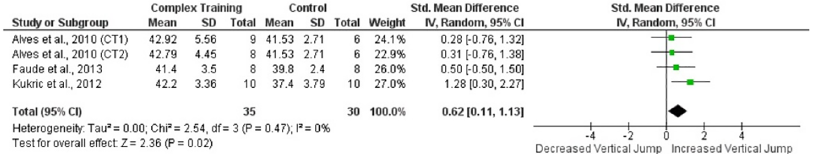
Fig 5. Standardized mean difference (SMD) in post-intervention VJ between CT-trained and control subjects. Squares representthe SMD a for each trial. Diamonds represent the pooledSMD across trials.